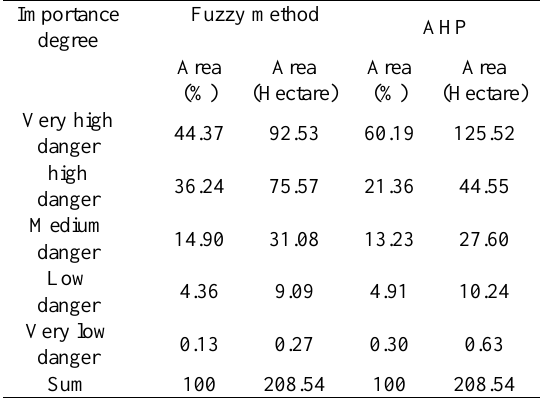
Table 5. The results of the real deforestation areas in each zone of deforestation risk